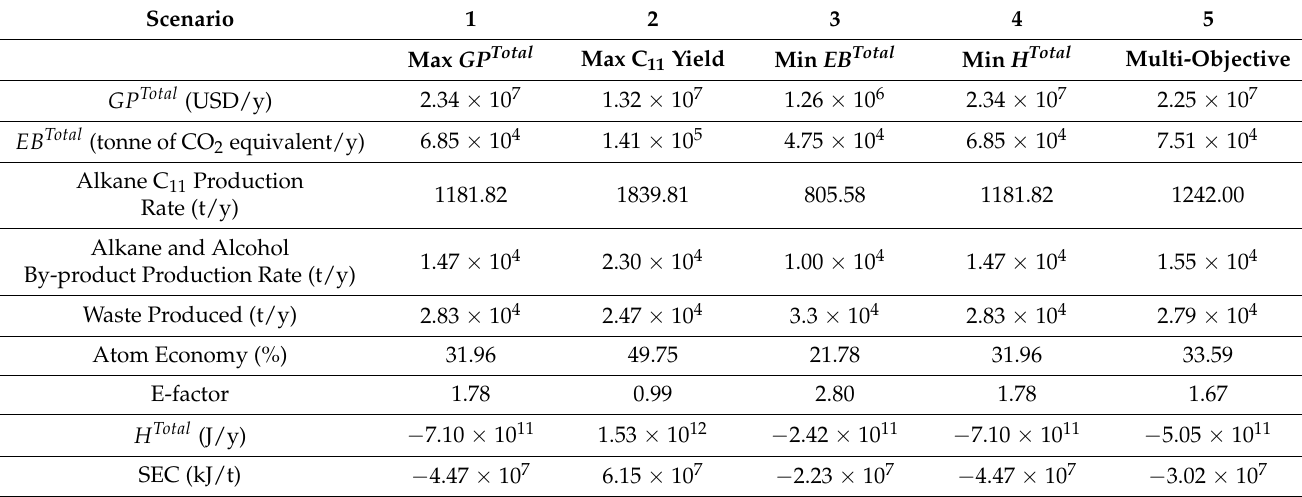
Table 11. Comparison between different